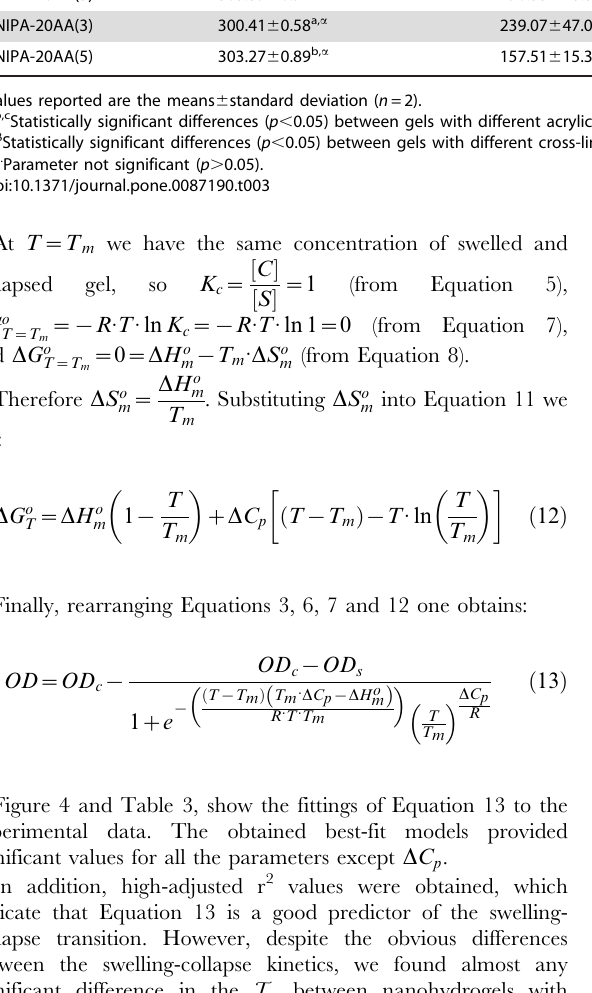
Figure 5. Differential scanning calorimetry (DSC) analysis of PNIPA/AA nanohydrogels. PNIPA(5) ( nanohydrogels were previously swelled in distilled water (12.5 mg mL 2 1 ) at 25 u C.